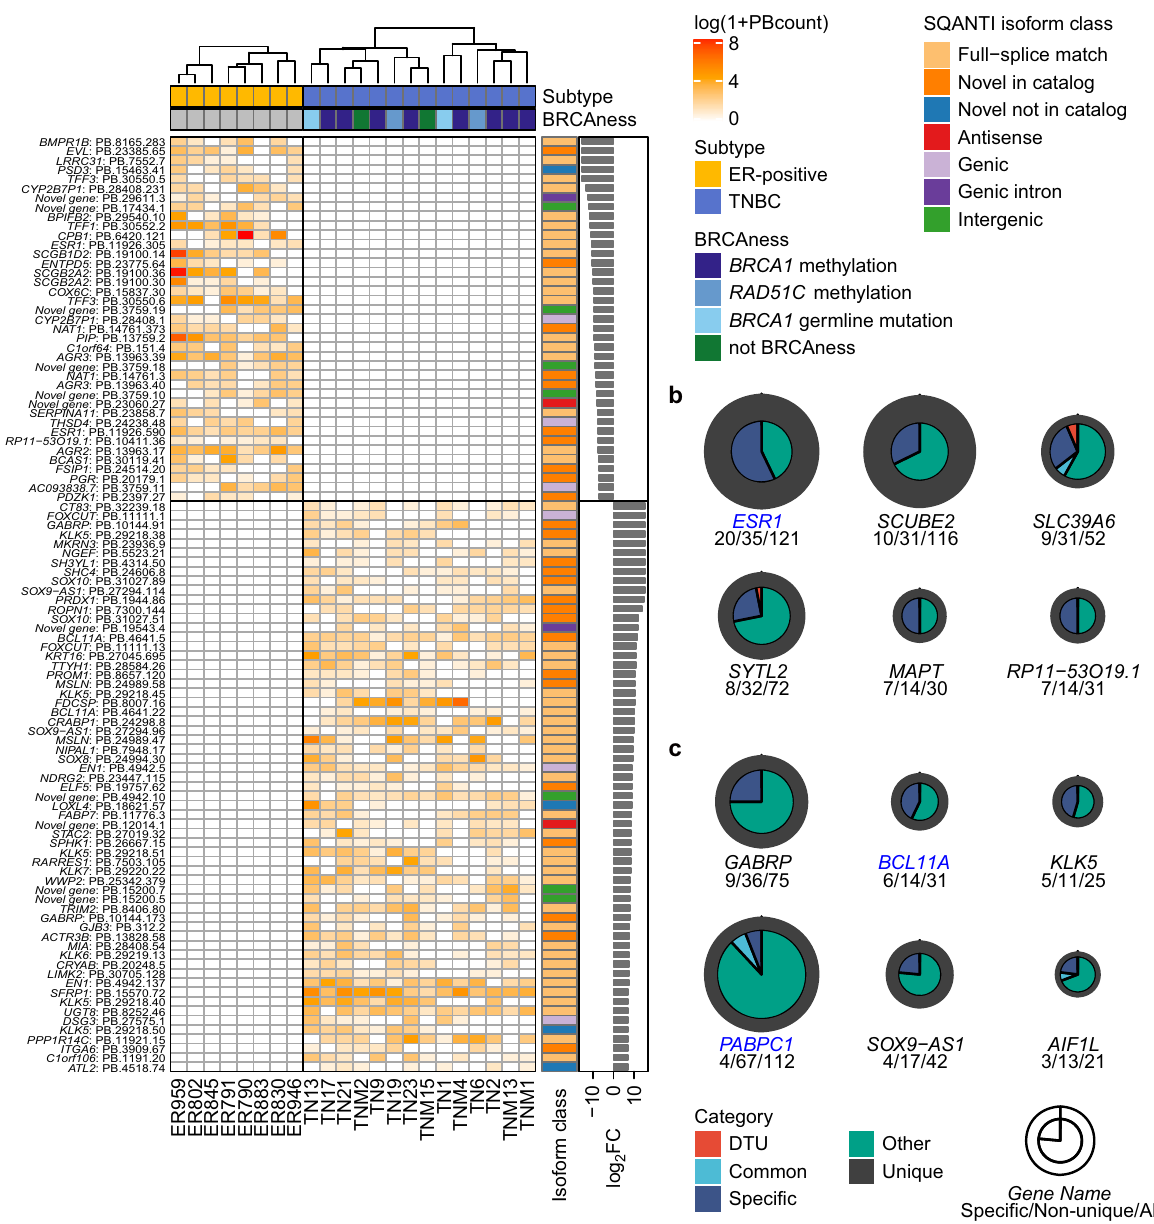
Fig. 3 Subtype-speci fi c isoforms re fl ect relationships between cancer genes and subtypes. a The top 100 subtype-speci fi c isoforms with the highest fold changes in transcript per million (TPM). Log-transformed PBcount data in each sample are indicated in the heatmap. Subtype and BRCAness are annotated for samples (top), and isoform classi fi cation by SQANTI and log 2 TPM fold change are annotated for isoforms (right). Absolute values of log 2 fold change greater than 10 were truncated. b , c Circular plots indicating the number of isoforms according to isoform categories de fi ned in Fig. 2d and differential transcript usage (DTU). b ER-speci fi c. c TN-speci fi c. Gene symbols of oncogenes are colored in blue. The three numbers below each gene symbol